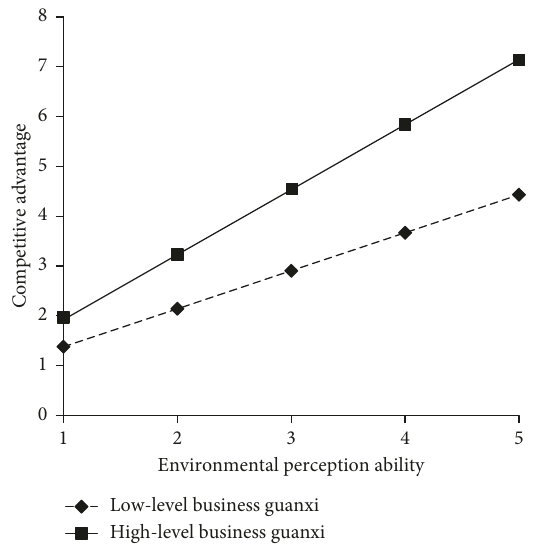
Figure 2: The interaction of environmental perception ability and business guanxi.